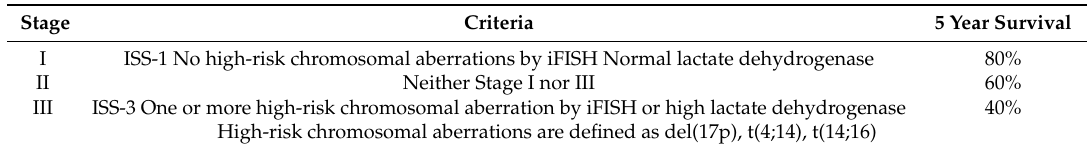
Table 2. IMWG revised International Staging System (R-ISS)